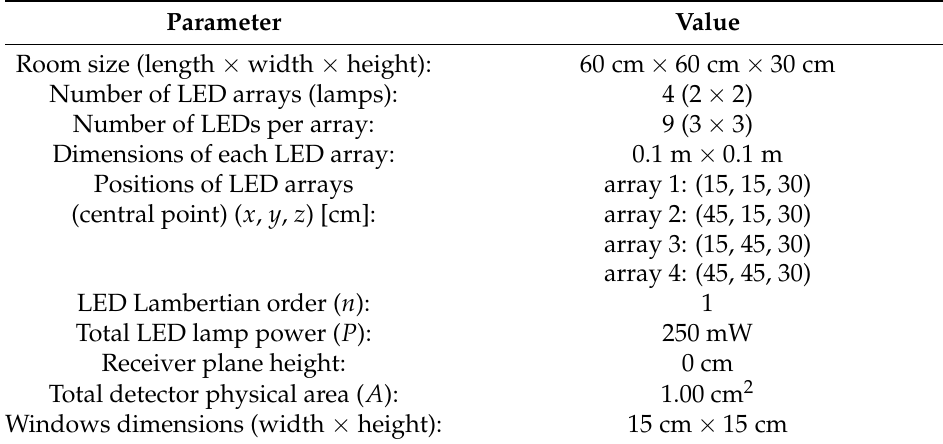
Figure 8. Received power throughout the room when the orientation method defined in Equation (14) is used: ( a ) Power balance. ( b ) Contour map of LOS component percentage in the total received power. ( c ) Elevation of the receiver as a function of its position. ( d ) Azimuth of the receiver as a function of its position. Table 2. Parameters of Simulation for Mockup